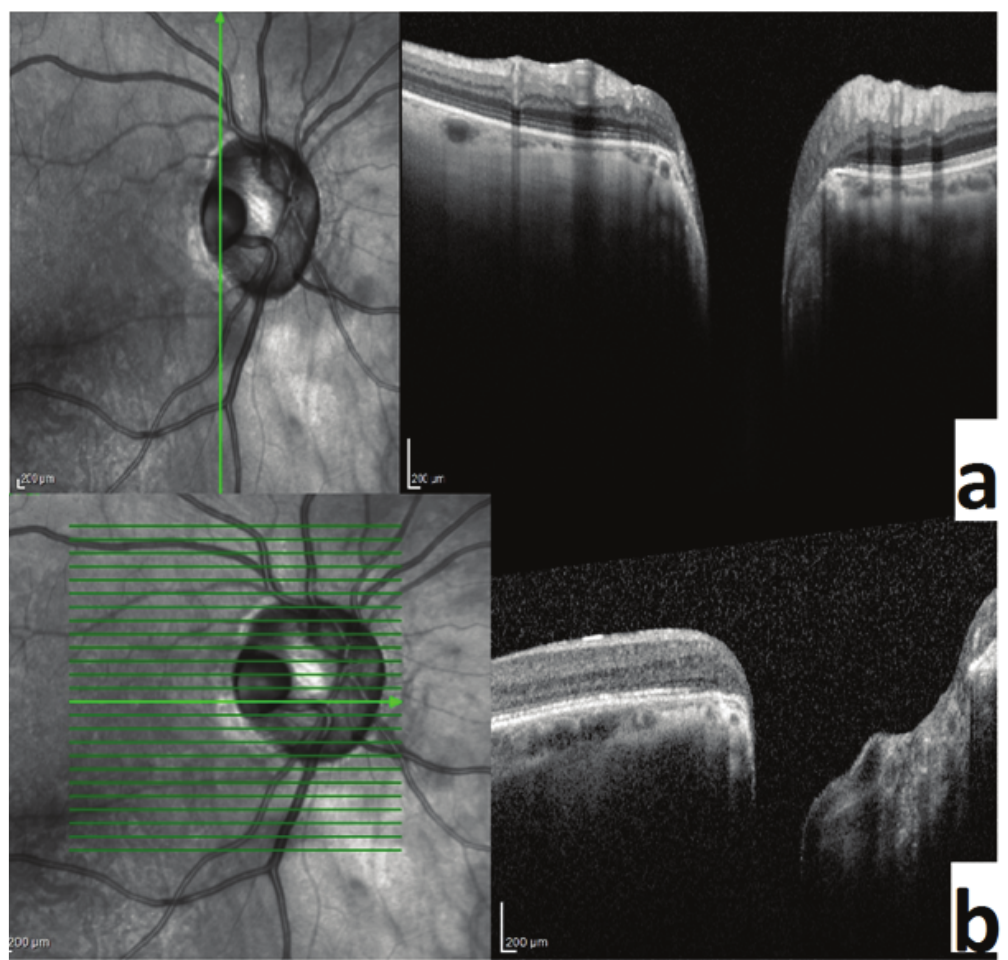
Figure 2. (a&b) Horizontal and vertical sections of the spectral domain optical coherence tomography scans of the right eye show the presence of cavitation in the disc